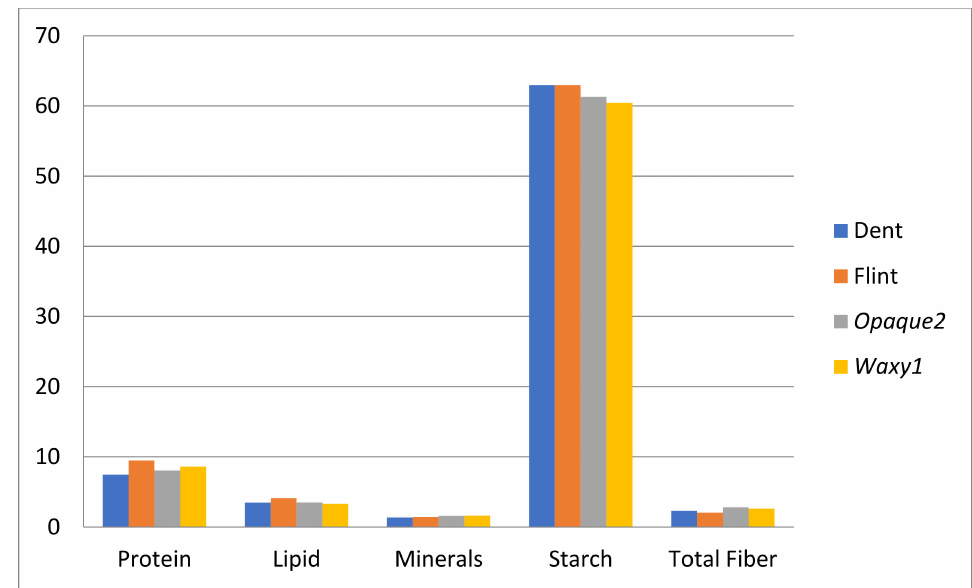
Figure 2. Percentage of nutrients (protein, lipid, ash, starch, and total fiber) in grain of four maize endosperm types (dent, flint, opaque2 and waxy1